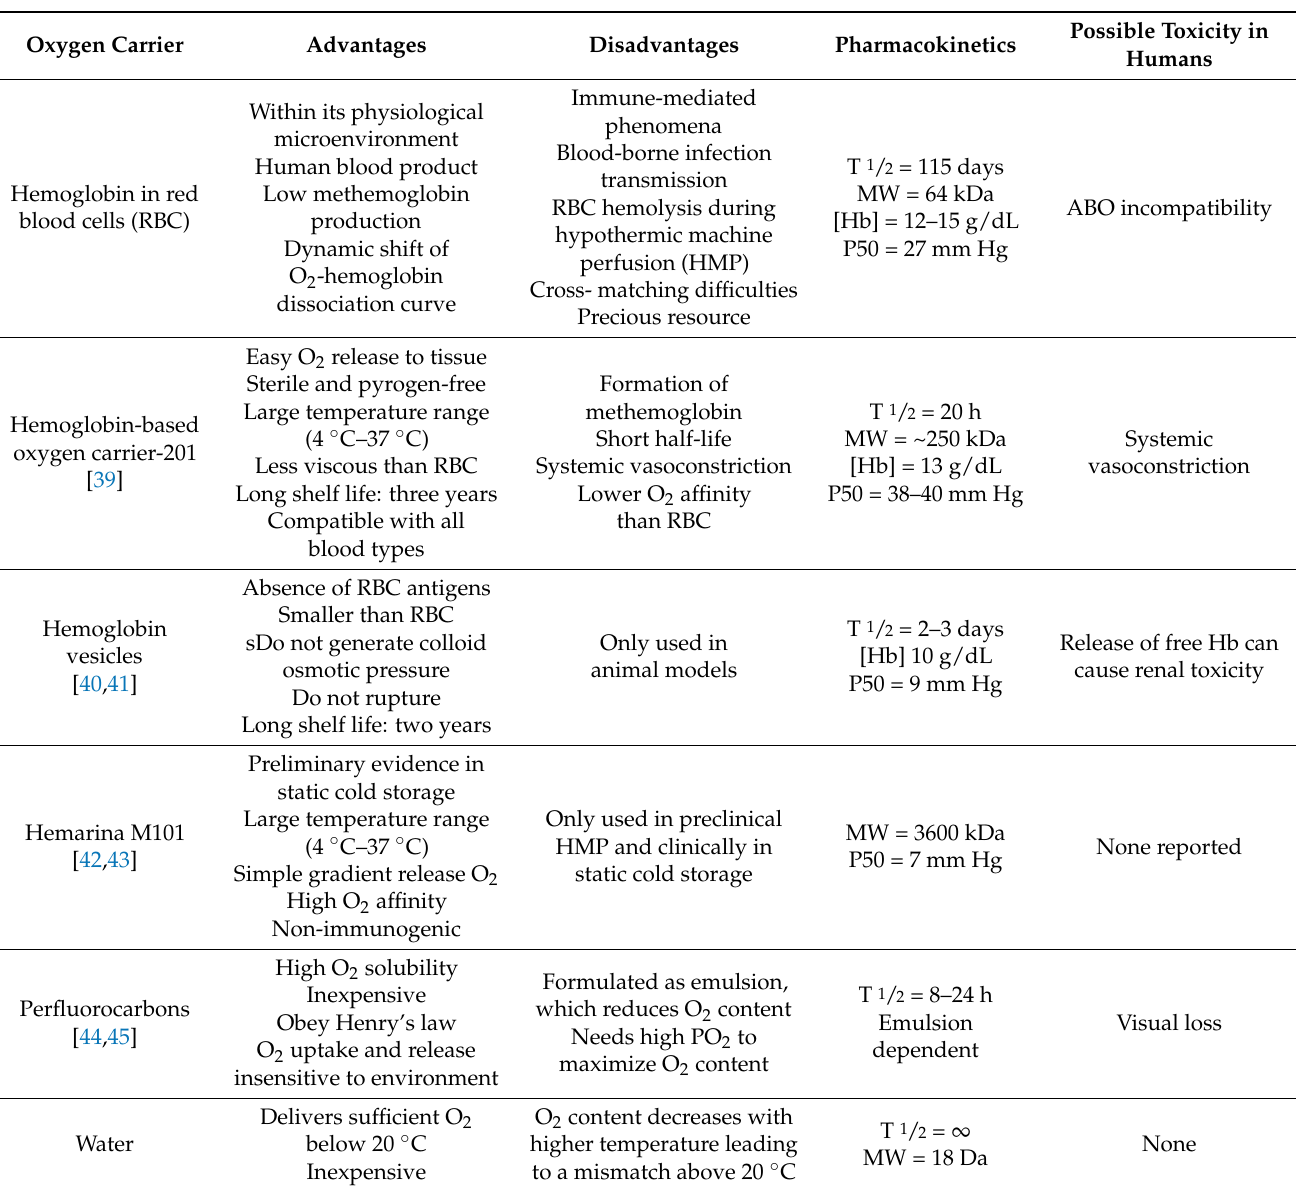
Table 1. Overview of the advantages and disadvantages of different oxygen carriers.